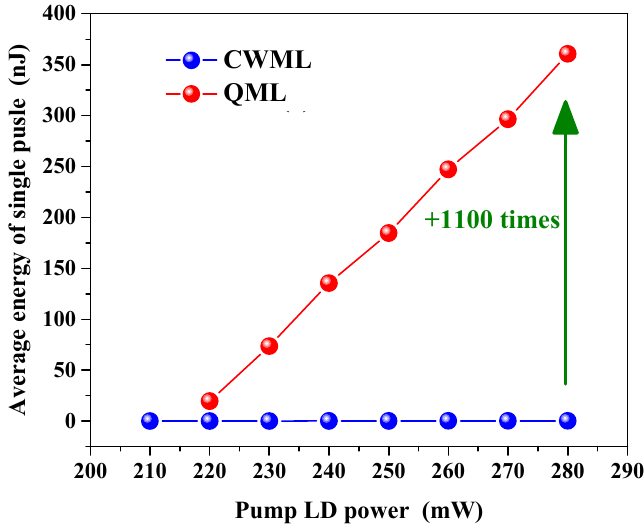
In addition, the minimum power is 17.65 mW, the maximum is 18.50 mW, and the average Figure 9. Average energy of single mode-locked pulse versus the pump at CWML and QML